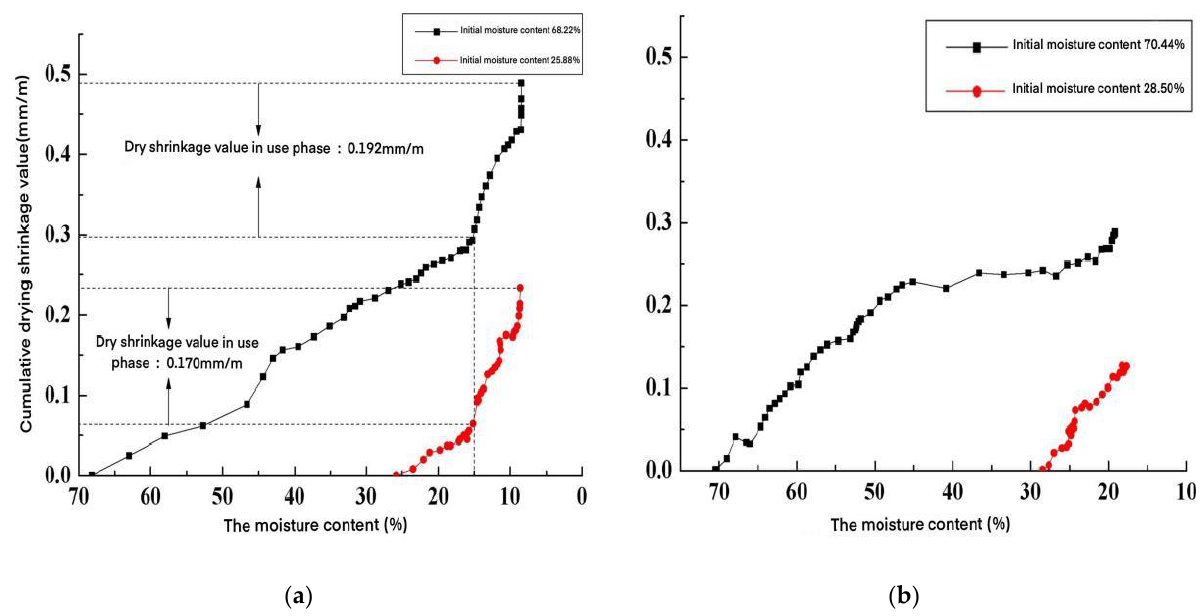
Figure 8. Change pattern of the cumulative drying shrinkage value during tests of moisture content